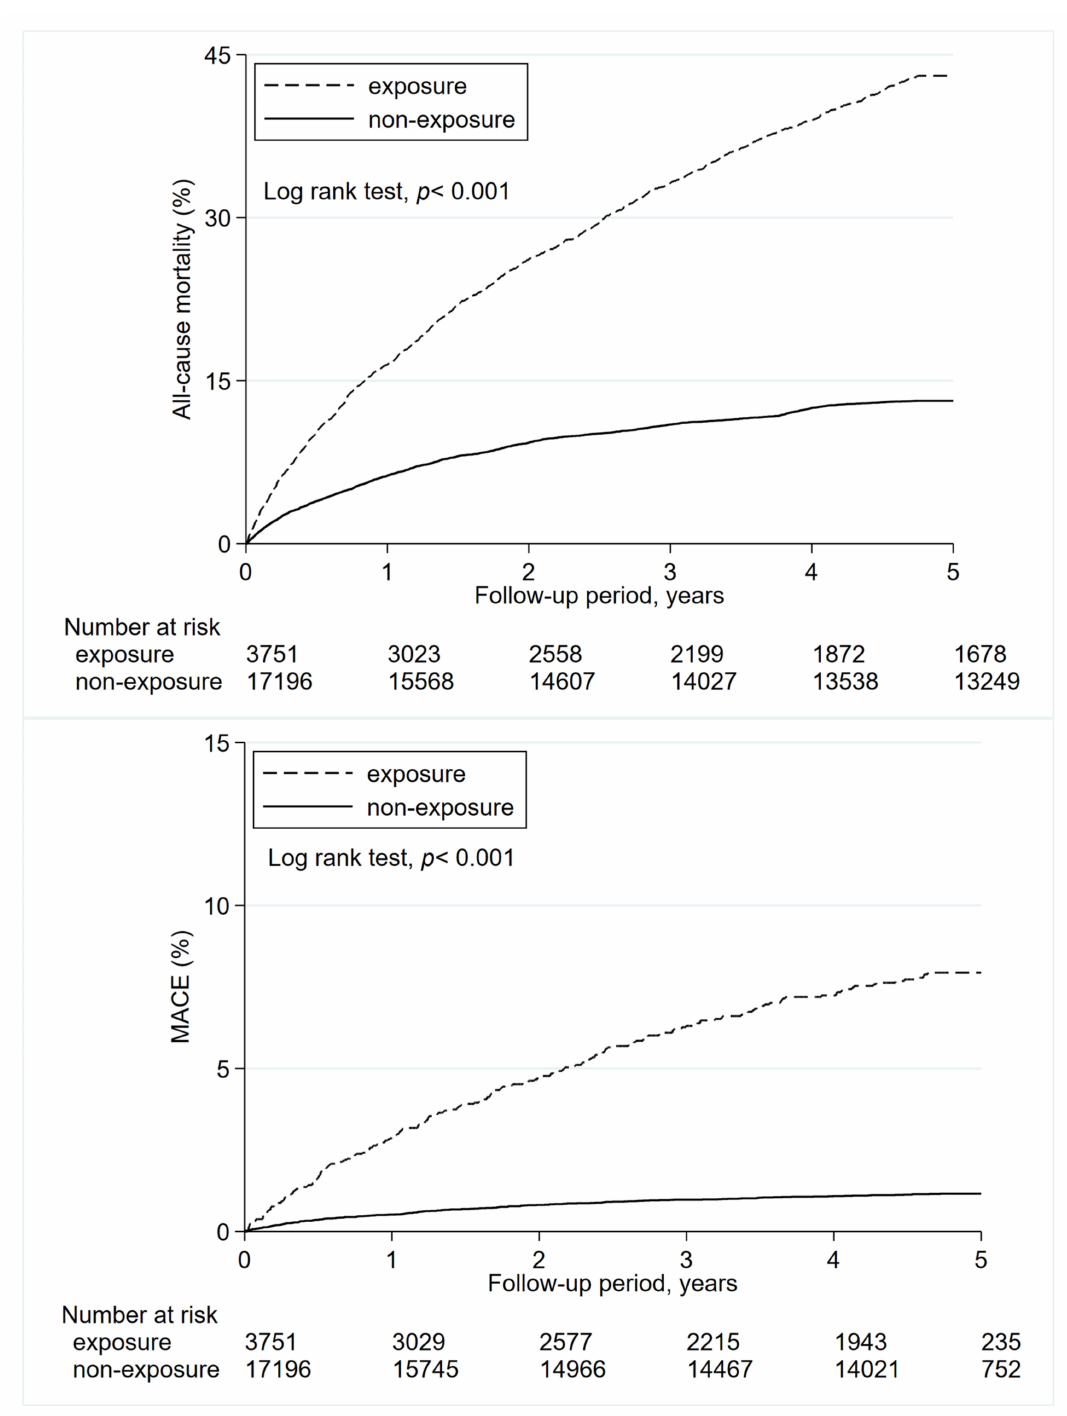
Figure 2. Cumulative risk curves of all-cause mortality and major adverse cardiovascular events for the study cohorts with ICM-CT and non-ICM-CT